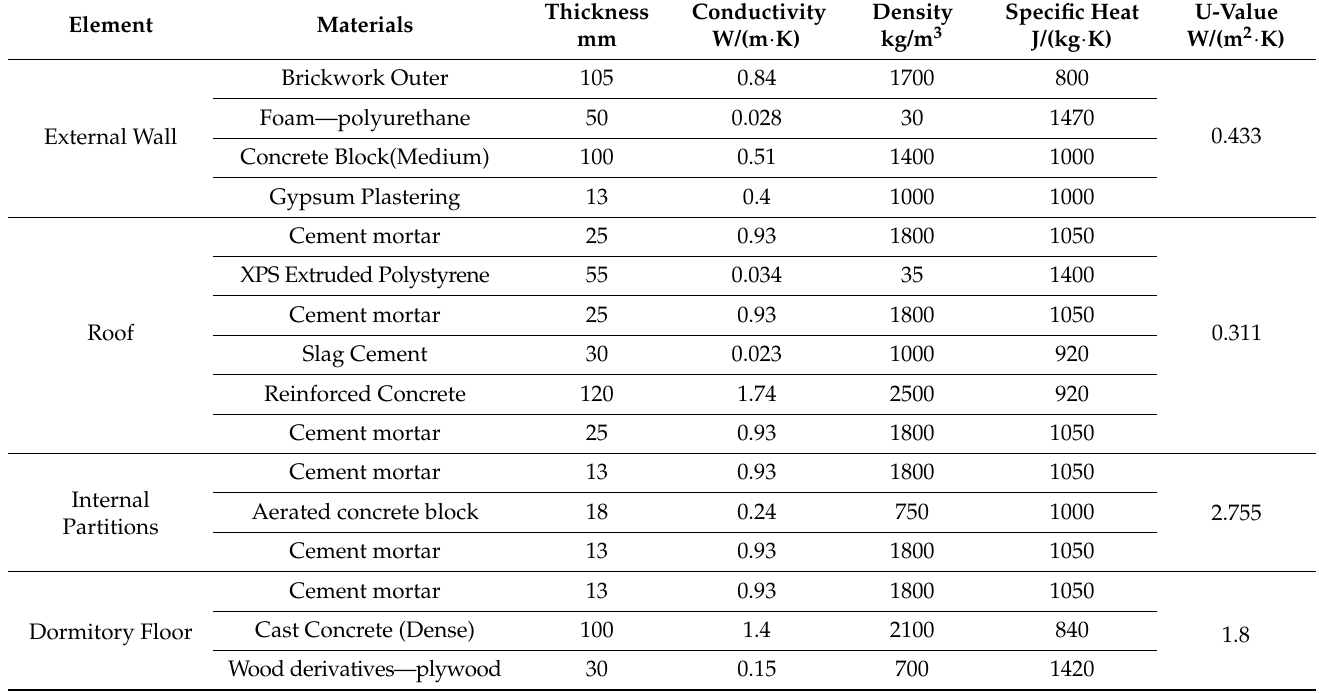
Figure 4. Graphs showing ( a ) top floor plan and ( b ) 3-dimensional geometry model of the office building. Table 1. Building construction and opening information.